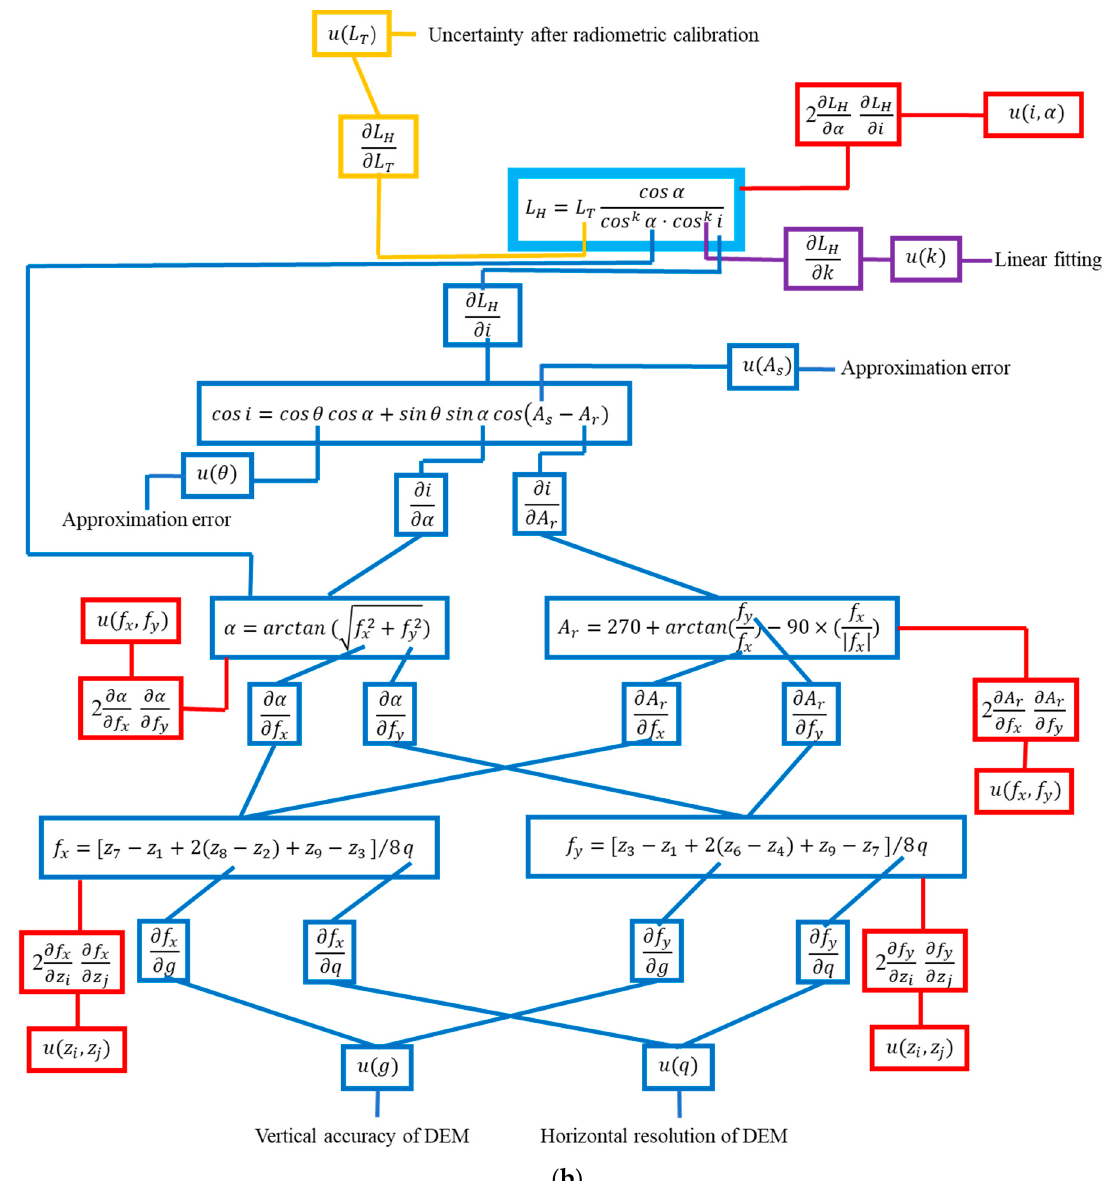
Figure 3. Uncertainty propagation chain of: ( a ) C correction; ( b ) Minnaert correction.